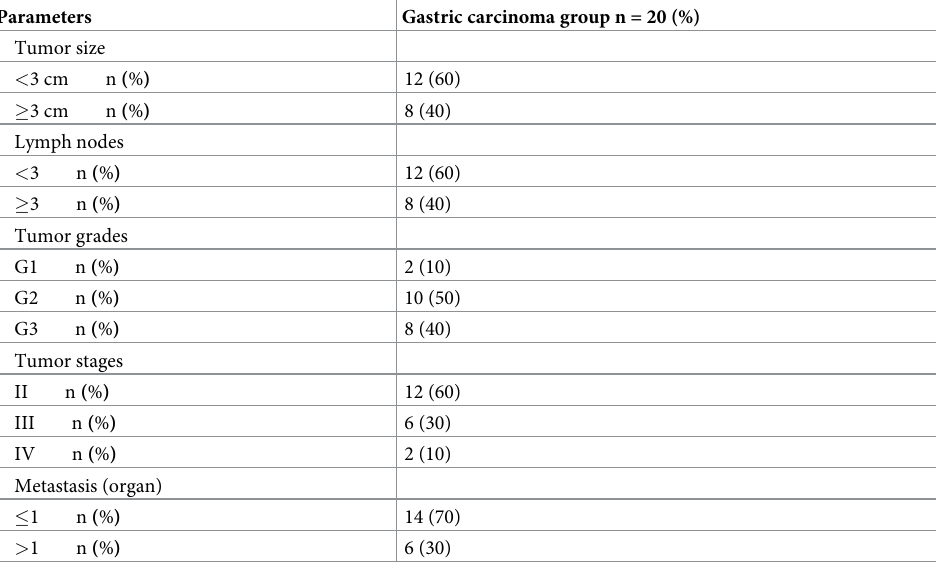
Table 1. The disease characteristics among the gastric carcinoma